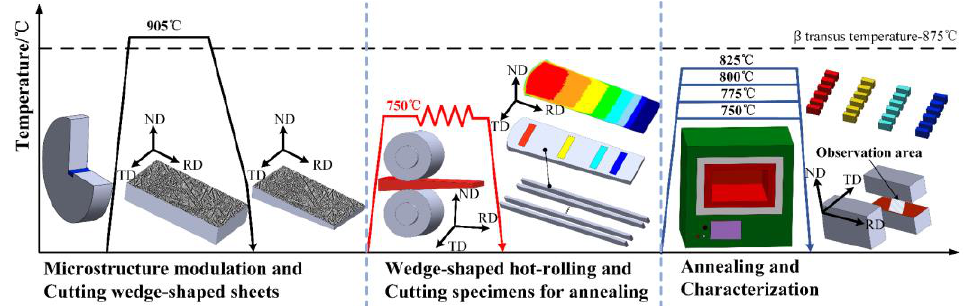
Figure 1. Schematic illustration of the experimental process.